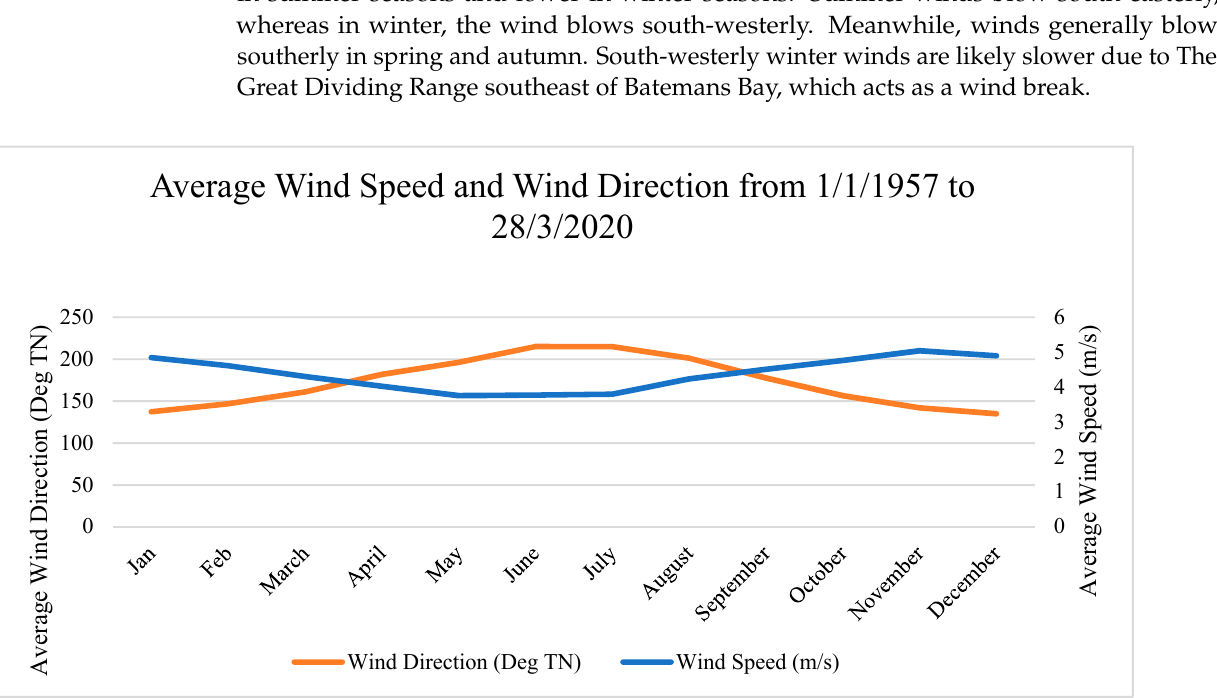
Figure 5. Graph of the average wind speed and wind direction from 1957-01-01 to 2020-03-28 from the Moruya Airport weather station.